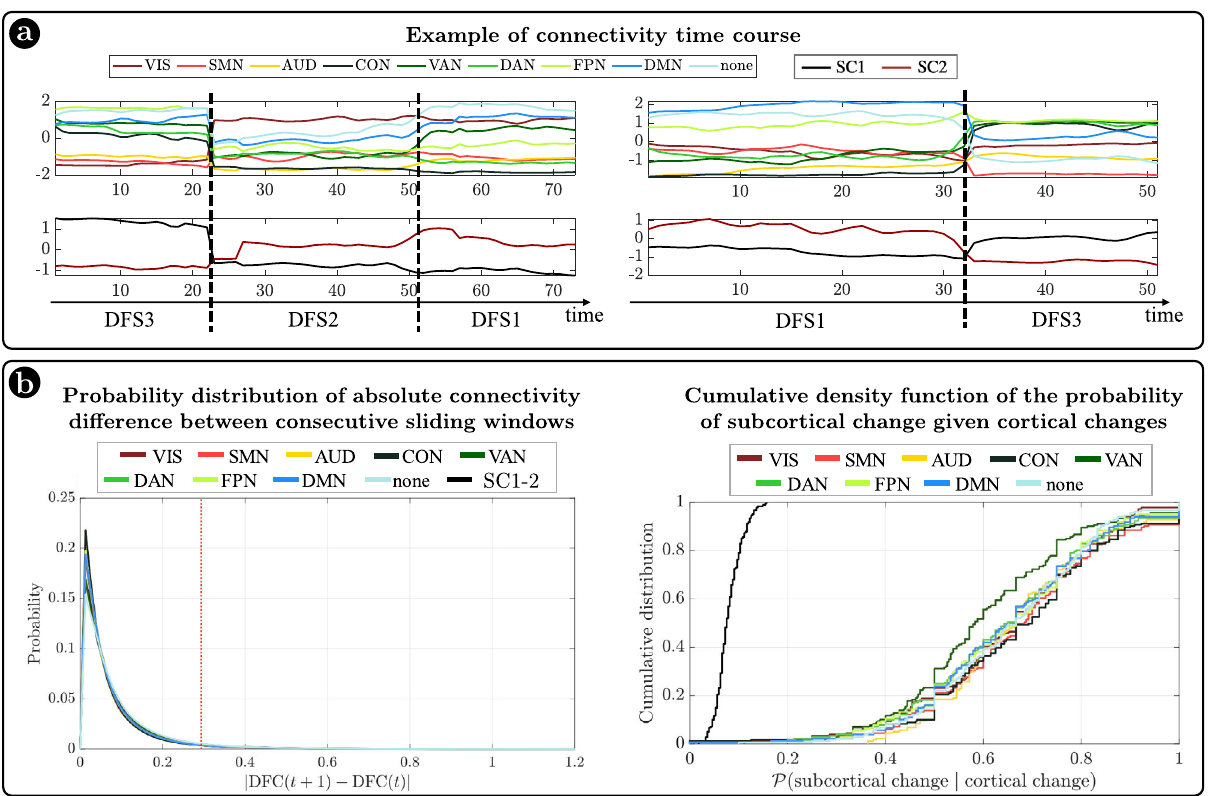
Fig. 4 | Cortical and subcortical dynamics. a Two examples of average con- nectivity during time for cortical networks (top) and subcortical clusters (bottom). The vertical dashed lines indicate the switching between dynamic functional states (DFSs). b (Left) Probability distribution of the absolute values of connectivity dif- ferences between consecutive sliding windows. Each line represents a different